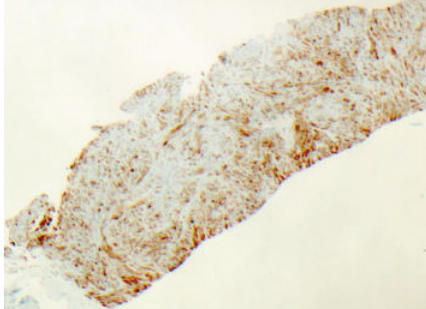
Figure 3: Haematoxylin and eosin staining showing spindle cell neoplasm composed of bundles of bland-looking spindle cells with eosinophilic cytoplasm ( × 40 magnification).